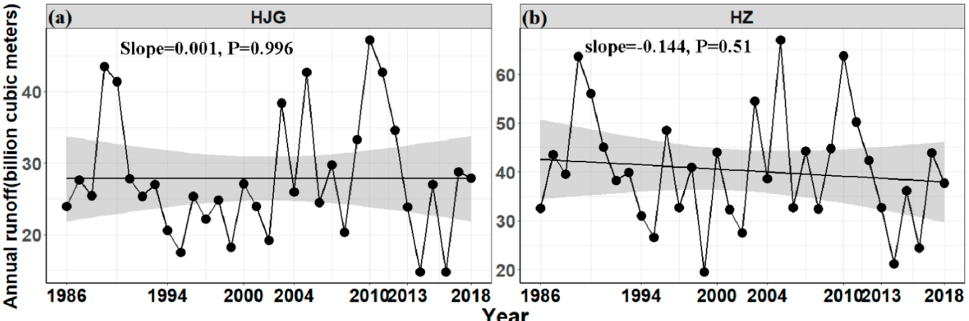
Figure 9. Annual runoff at Huangjiagang (HJG) and Huangzhuang (HZ) stations (the grey range is the 95% confidence interval).